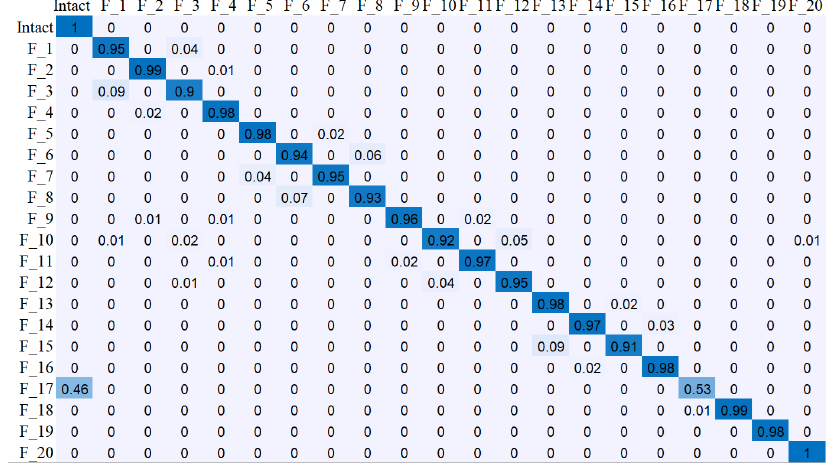
Figure 14. Failure detected location when there are 5 sensors at points 2, 3, 5, 7, and 8 (Accuracy: 94.2%). Appl. Sci. 2020 , 10 , x FOR PEER REVIEW